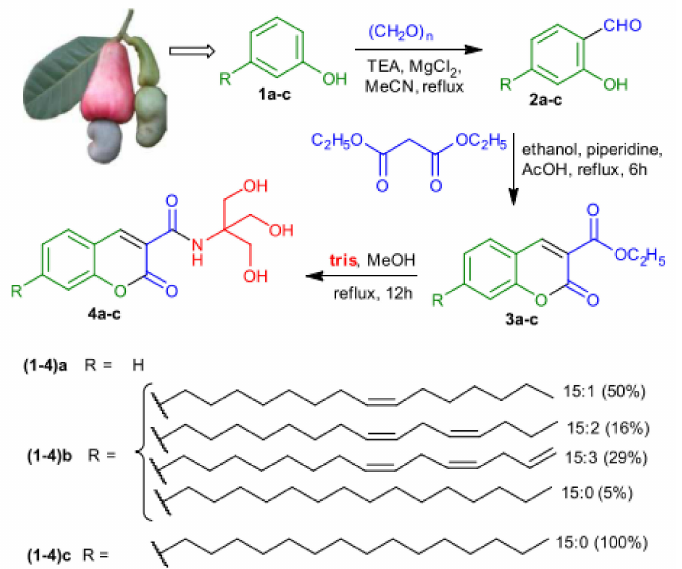
Figure 30. Synthesis of coumarin coupled tris amphiphile 4a-c. Adapted with permission from [112,157]. Copyright 2015©, Royal Society of Chemistry,